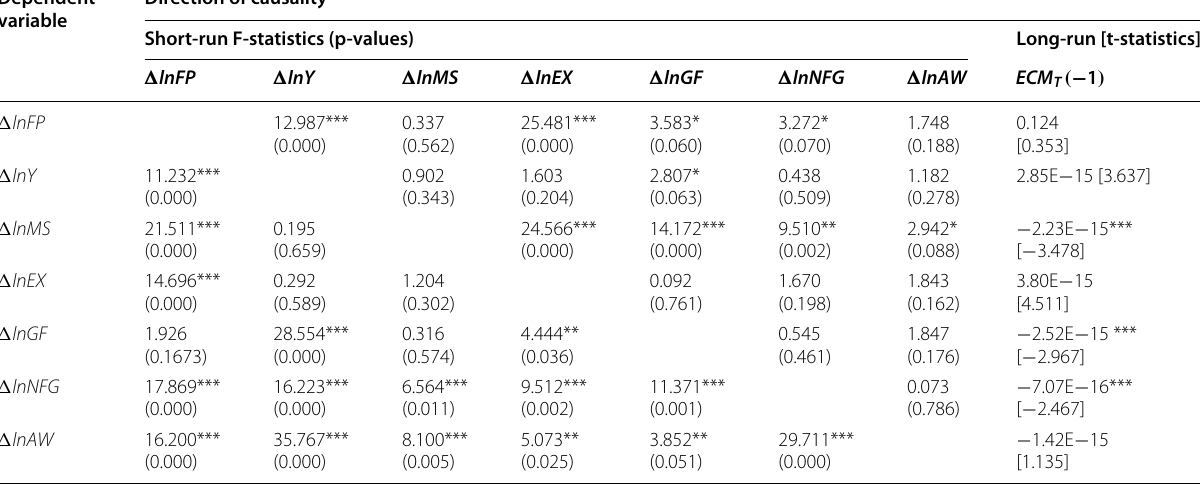
*, ** and *** indicate significance at the 10%, 5% and 1% significance levels, respectively